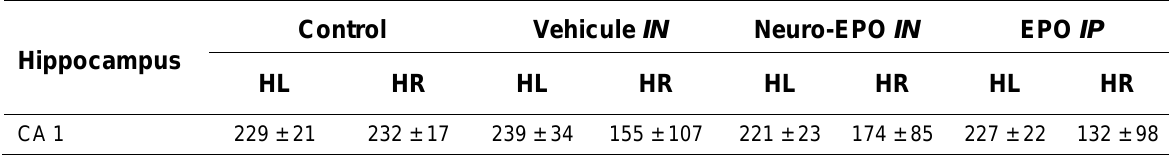
Linear Density of Healthy Neurons in Regions of the Hippocampus Control Vehicule IN Neuro-EPO IN EPO IP Hippocampus HL HR HL HR HL HR HL HR CA 1 229 ± 21 232 ± 17 239 ± 34 155 ± 107 221 ± 23 174 ± 85 227 ± 22 132 ± 98 Average values in neurons/mm. HL: left hemisphere; HR: right hemisphere. Kruskal-Wallis and Mann-Whitney. There were no differences between